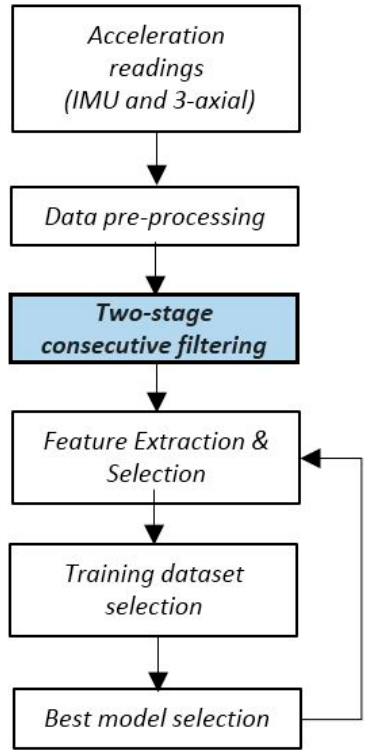
Figure 5. Scenarios with and without the new filtering